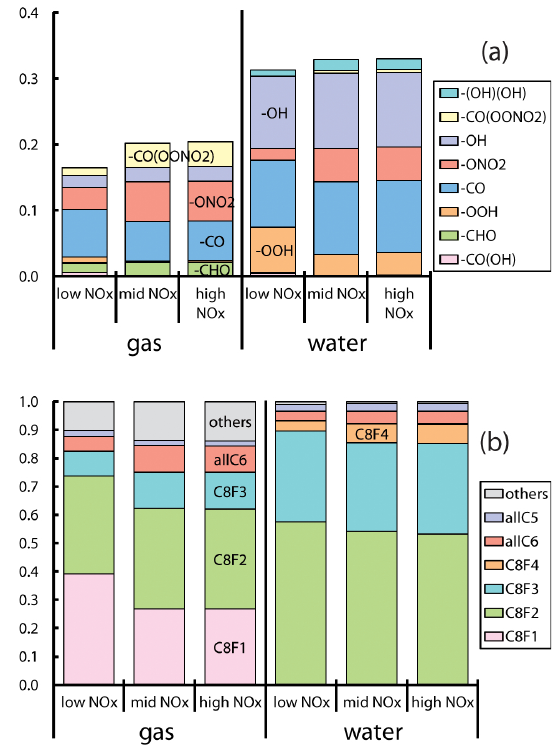
Fig. 4. At N τ = 2, simulated distribution in gaseous and aqueous phase of organic moieties ratio ( R OF / C , panel a ) and functionaliza- tion (panel b ) for a cloud water content during the oxidation of oc- tane. C m F n category merges species with m carbon atoms bearing n functional groups. The precursor and C 1 –C 4 species are lumped in the others